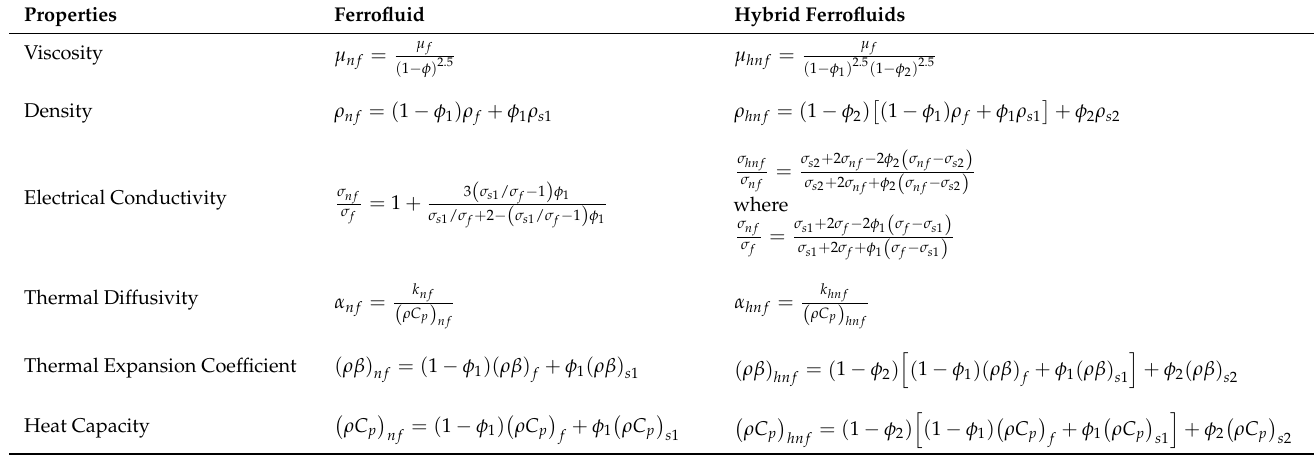
Table 1. Theoretical models for properties of the ferrofluid and hybrid ferrofluids [37,50,70].